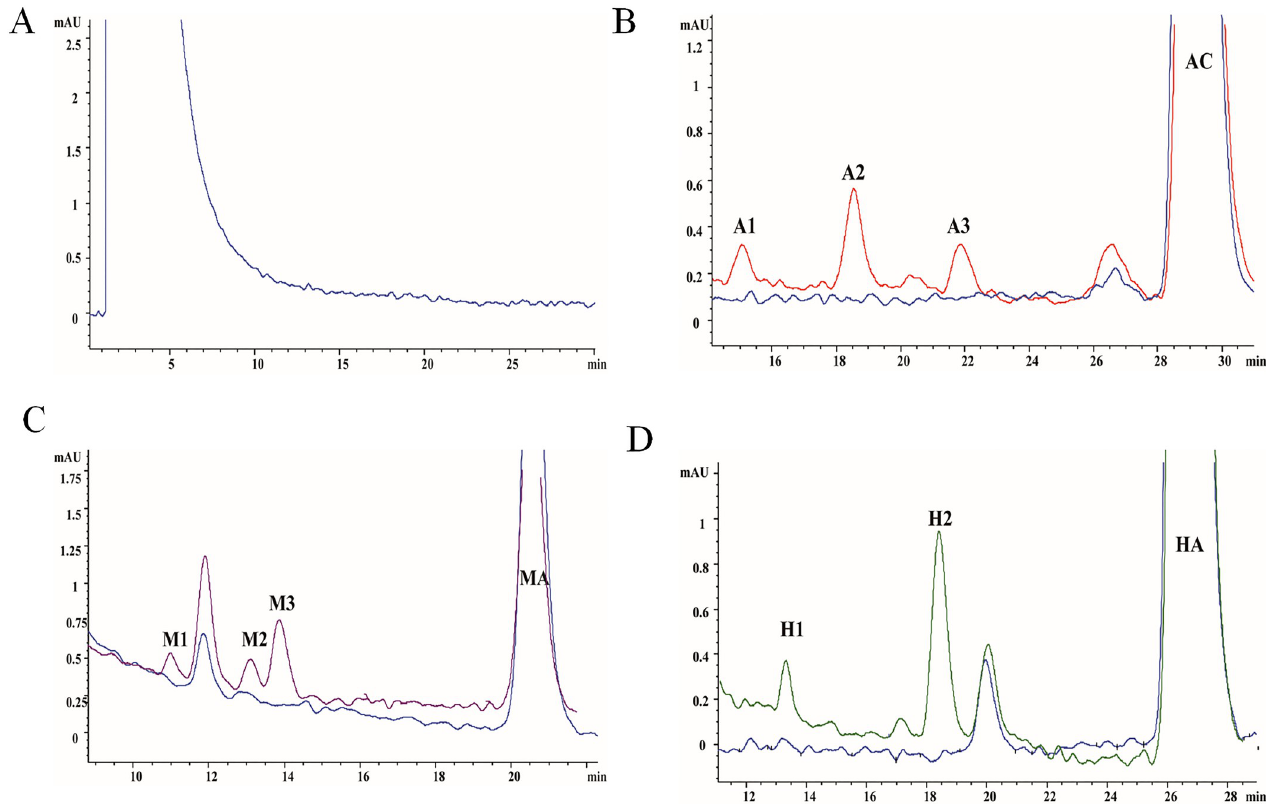
Fig 1. HPLC chromatogram of toxic components and metabolites of Aconitum in Rat Liver Microsomes (RLM). 1 mg / ml microsome 100 μ L, PBS 75 μ L and aconitine alkaloids 5 μ L (1 mmol / L) were added in turn, AC and HA were incubated for 90 min, MA were incubated for 120 min for HPLC respectively. (A) HPLC chromatograms of blank microsome sample. (B) HPLC chromatograms of AC and its metabolites in RLMs. (C) HPLC chromatograms of MA and its metabolites in RLMs. (D) HPLC chromatograms of HA and its metabolites in